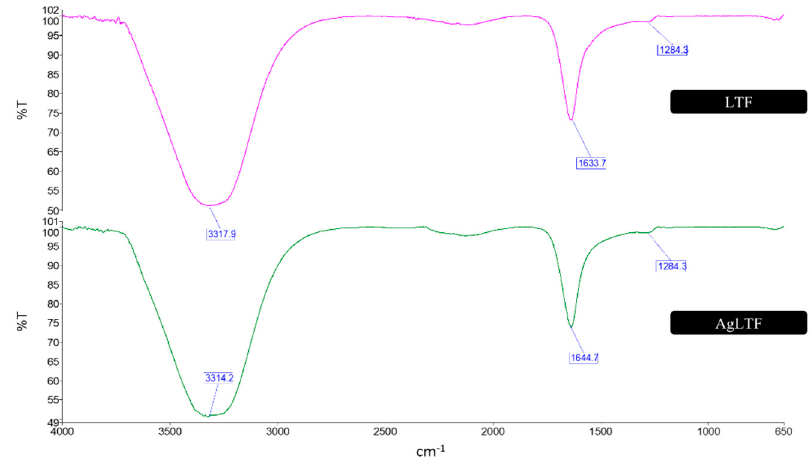
Figure 2. FTIR spectrum of LTF and AgLTF.